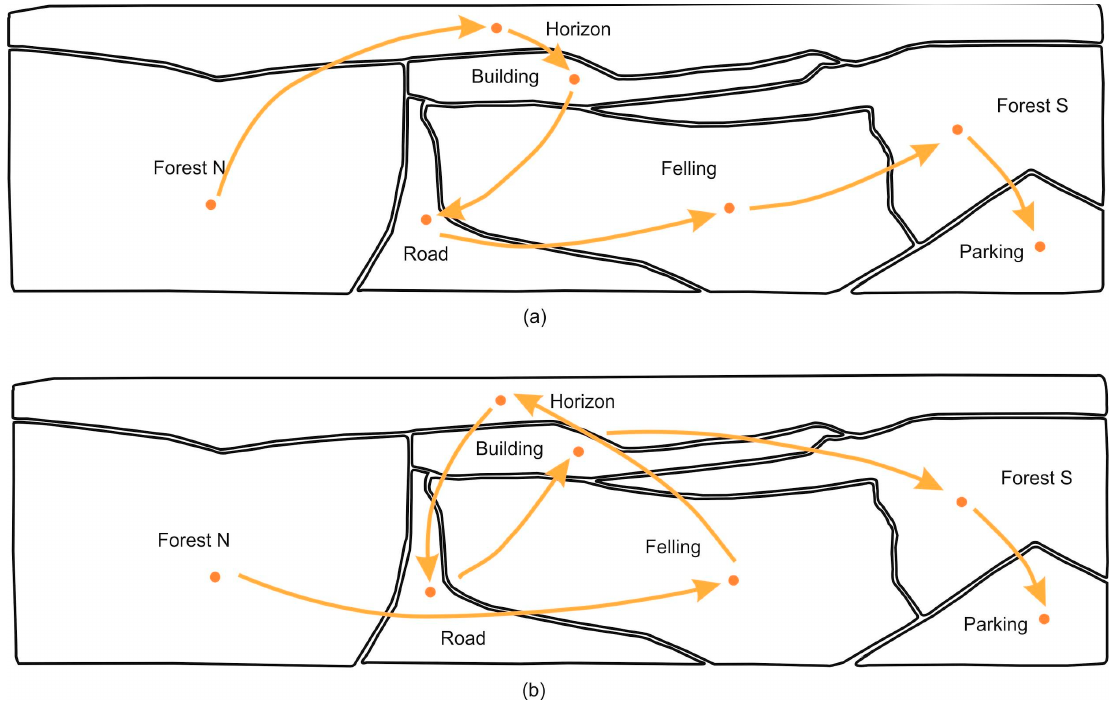
Figure 6. Sequence of visits in areas of interest designated for the analysis during ( a ) positive and ( b ) negative weather conditions.